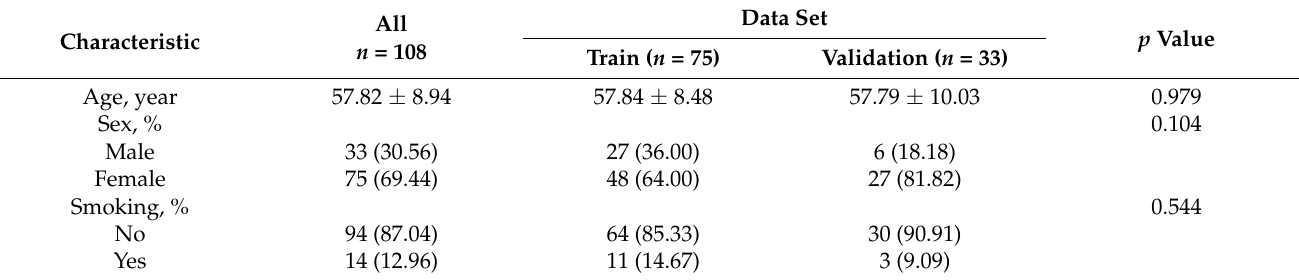
Table 1. Characteristics of